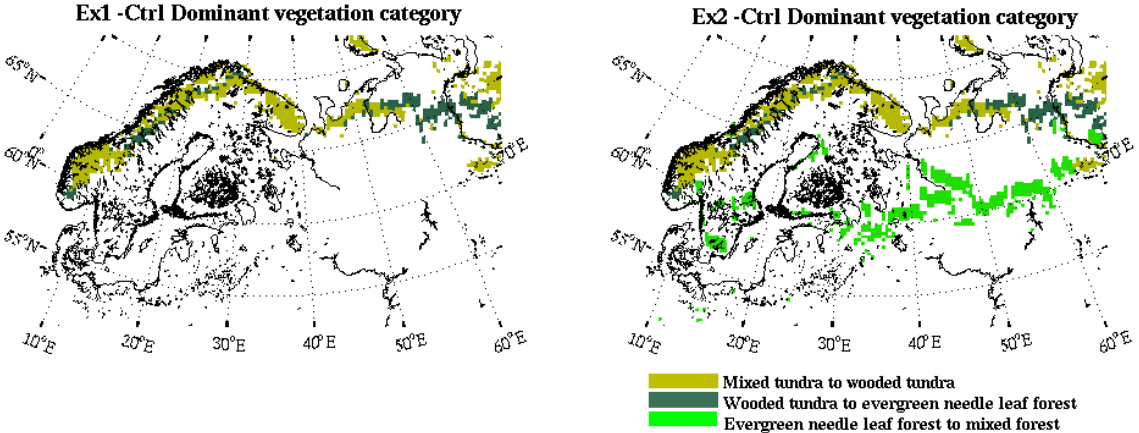
Figure 2. Changes in dominant vegetation category as compared to the control simulation for Ex 1 (left panel) and Ex 2 (right panel). The olive-green color represents areas where the dominant category is changed from mixed tundra to wooded tundra to represent shrub expansion. Dark green indicates areas where the dominant land use category of wooded tundra has been replaced by evergreen needleleaf forest. Light green represents areas where mixed forest has taken over evergreen needleleaf forest (only Ex 2).